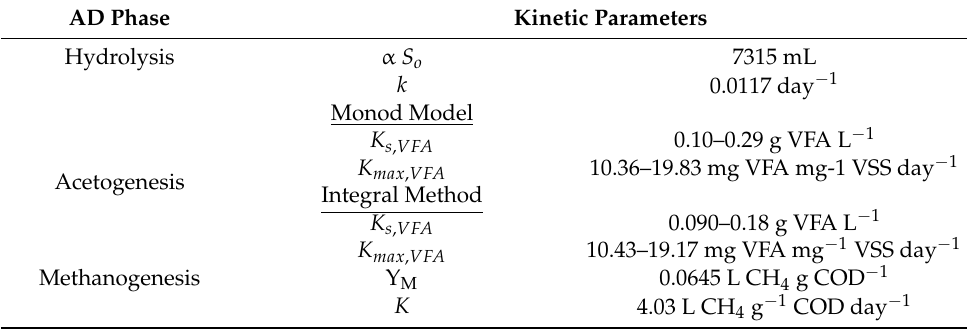
Table 5. Summary of kinetic